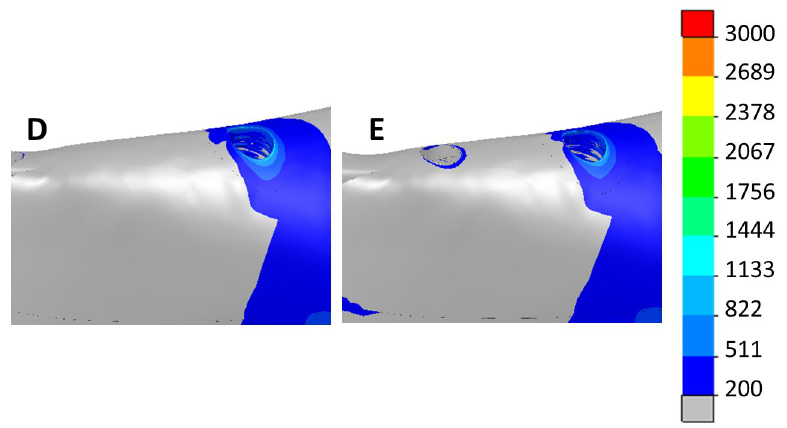
Figure 11. Distribution of the max. principal strain in scenarios with the two posterior implants distally to the foramina. Left—4 implants (D). Right—6 implants (E).